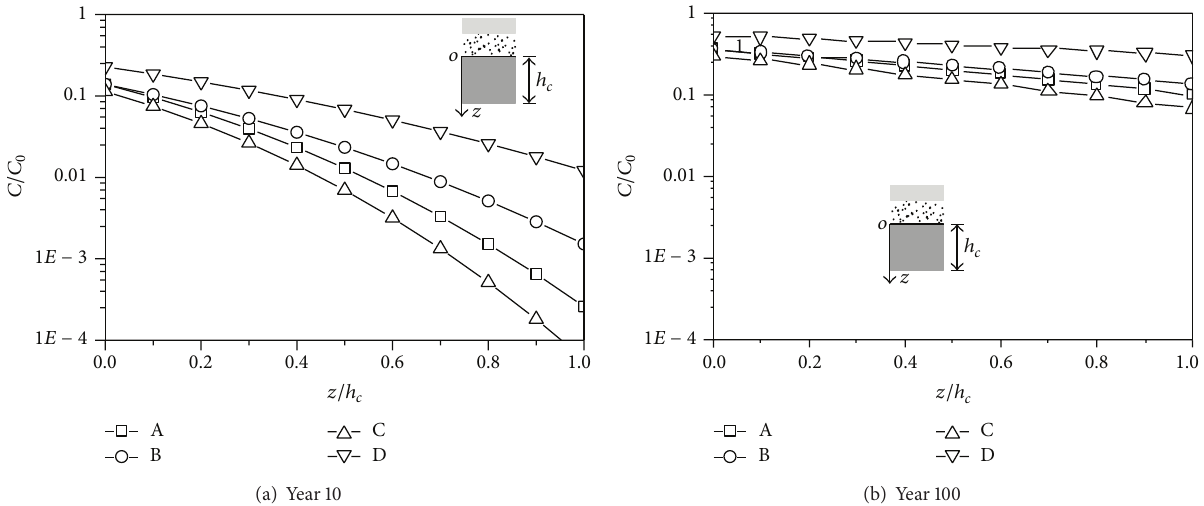
Figure 4: The concentration-depth curves of the dichloromethane.